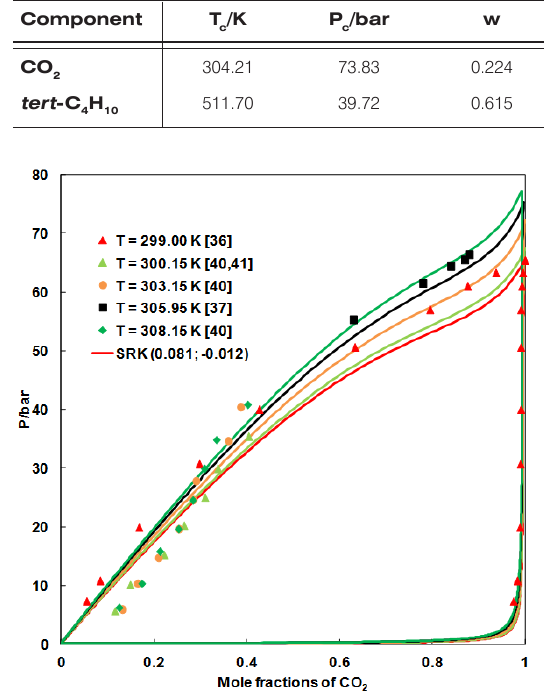
Figure 2. Comparison of literature data for the carbon dioxide + 2-methyl-2-propanol (tert-butanol) system and calculations by SRK model: symbols, literature data at different temperatures; solid lines, predictions by SRK ( k = 0.081, l = 12 12